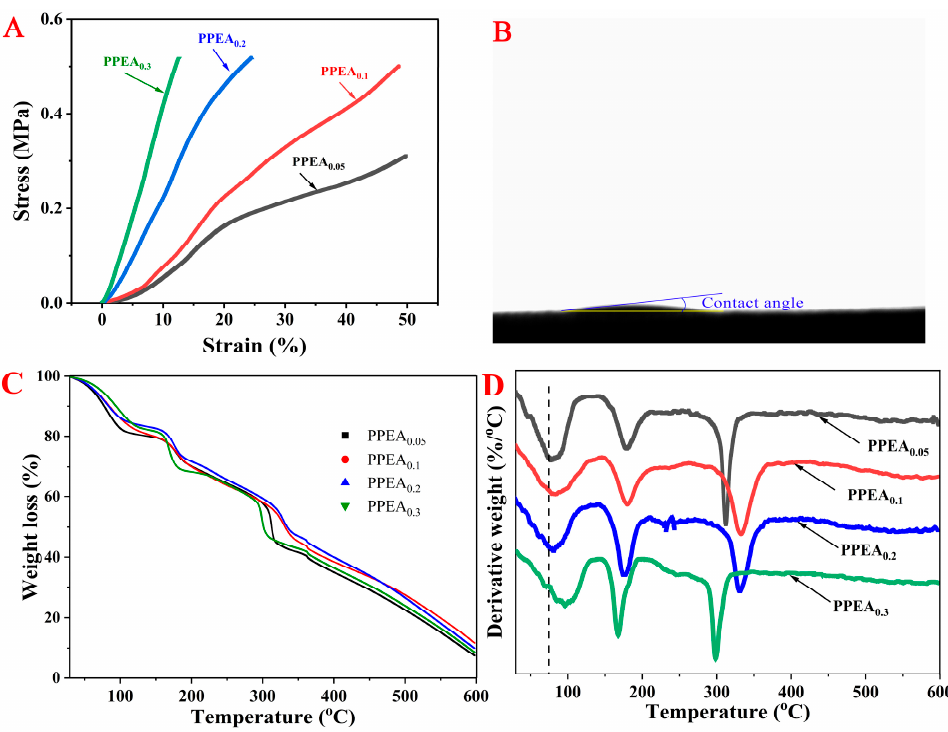
Figure 5. Compressive stress–strain curves of one compress–release cycle of PPEAs with strain up to 50% ( A ). Water contact angle of PPEA 0.03 as a representative ( B ). TGA patterns ( C ) and the corresponding derivative weight curves ( D ) of the PPEAs.